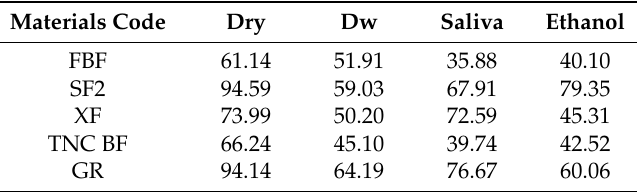
Table 5. Percentage of creep recovery